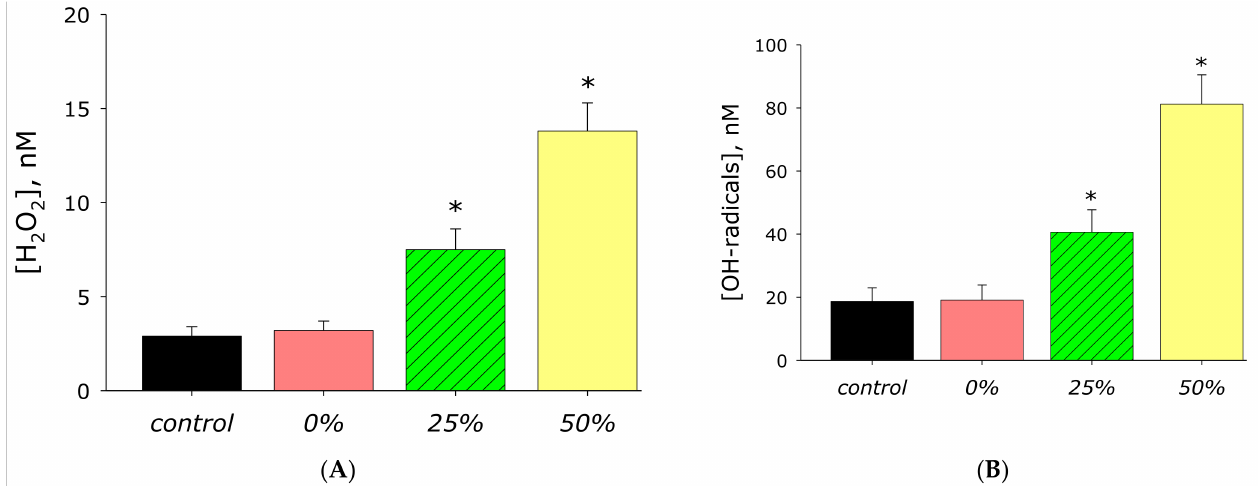
Figure 12. Effect of material AP-ZnO on the reactive oxygen species generation. ( A ) Generation of hydrogen peroxide (2 h, 40 ◦ C). ( B ) Generation of hydroxyl radicals (2 h, 80 ◦ C). * indicate a significant difference at 5% level in comparison with the control ( p < 0.05). Data are presented as mean values and standard errors.